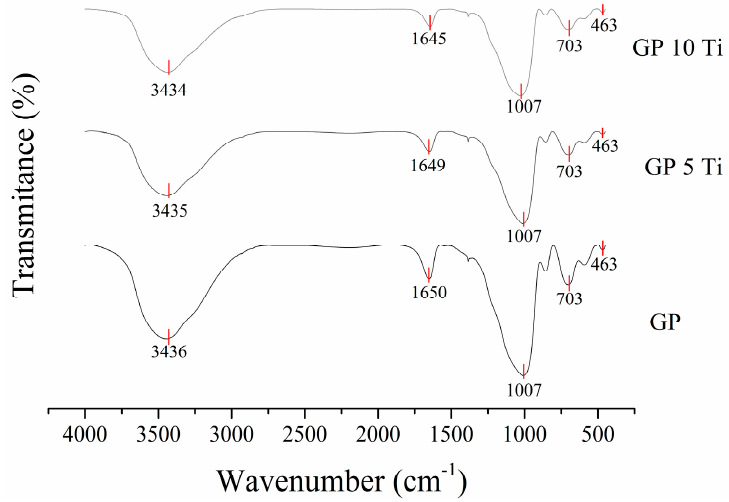
Figure 9. FTIR spectra of geopolymers.